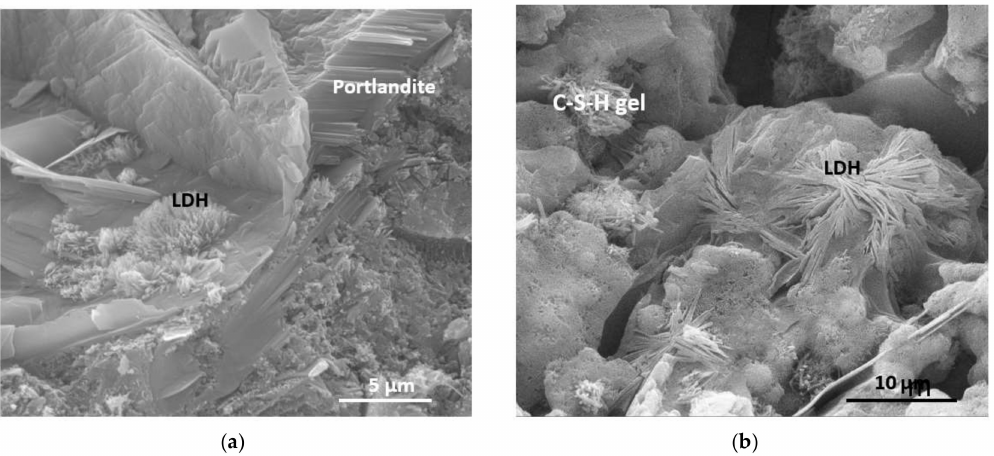
Figure 10. Materials observed by SEM: CSH gels type II and LDH compounds that grow over portlandite hexagonal crystals. ( a ) Portlandite LDH and compounds; ( b ) CSH gel and LDH